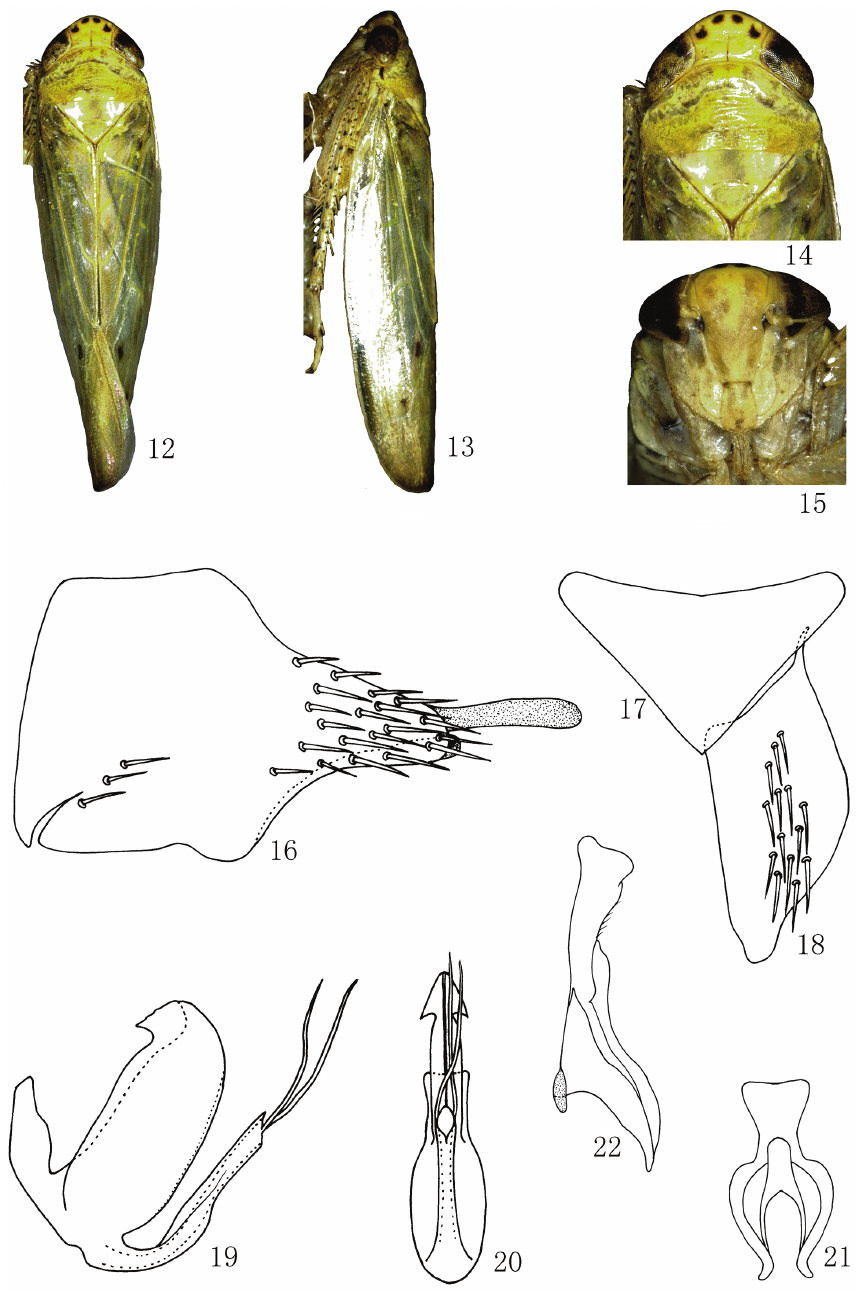
dorsal view 15 ♂ , face 16 Male pygofer side, lateral view 17 Valve, ventral view 18 Subgenital plate, ventral view 19 Aedeagus, lateral view 20 Aedeagus, caudal view 21 Connective, ventral view 22 Style, dorsal